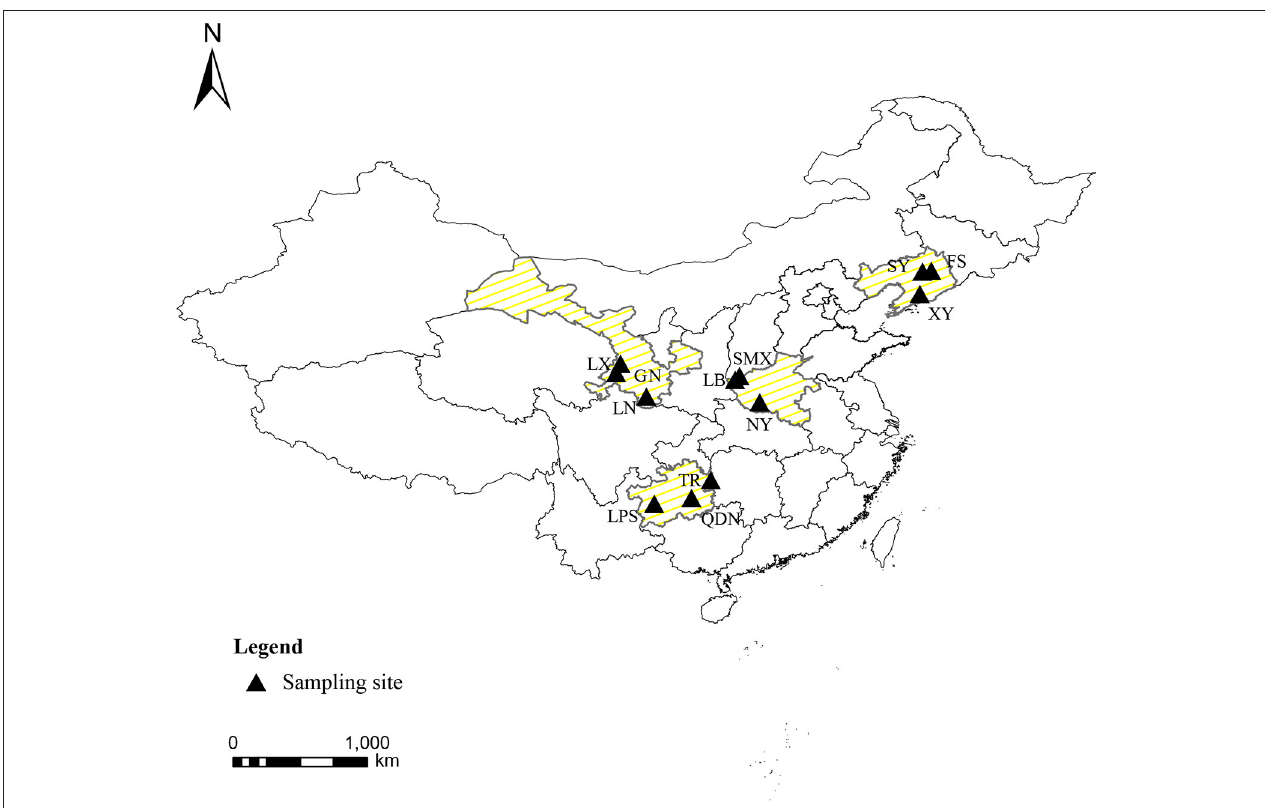
FIGURE 1 | Geographical distribution of the Morchella sp. samples.